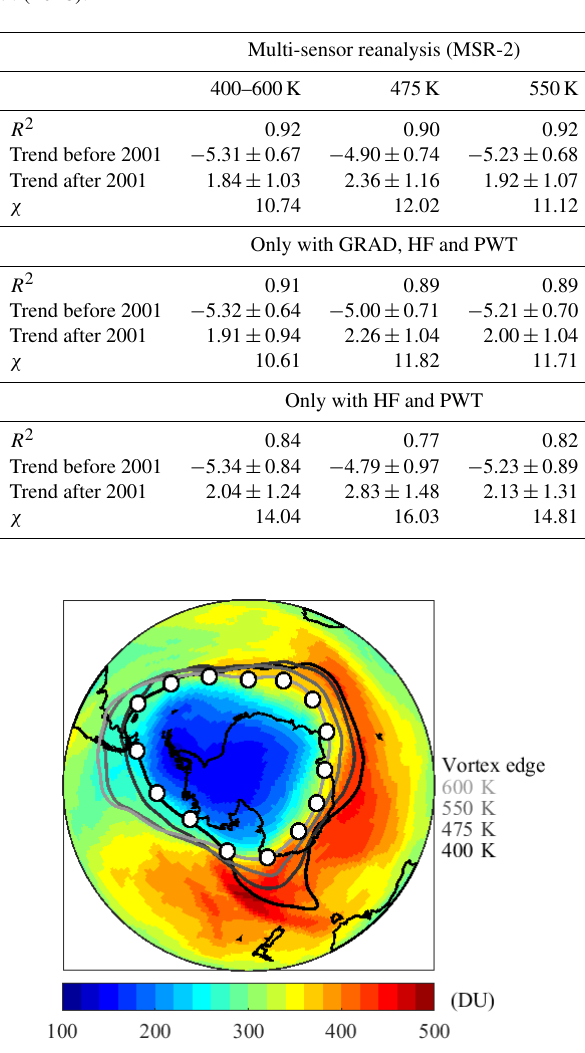
Table 2. Coefficient of determination R 2 and trends ± 2 σ in DUyr − 1 before and after the turnaround year 2001 derived from multi-regression model using as input MSR-2 (1980–2017) total ozone anomalies inside the vortex for September using three classi- fication methods described in Sect. 3.2. The residual is represented q P − mod i ) 2 /(n − m) , where obs i and mod i in DU by χ = i ( obs i correspond to observations and model monthly mean, n the num- ber of years and m the number of parameters fitted as in Weber et al. (2018).